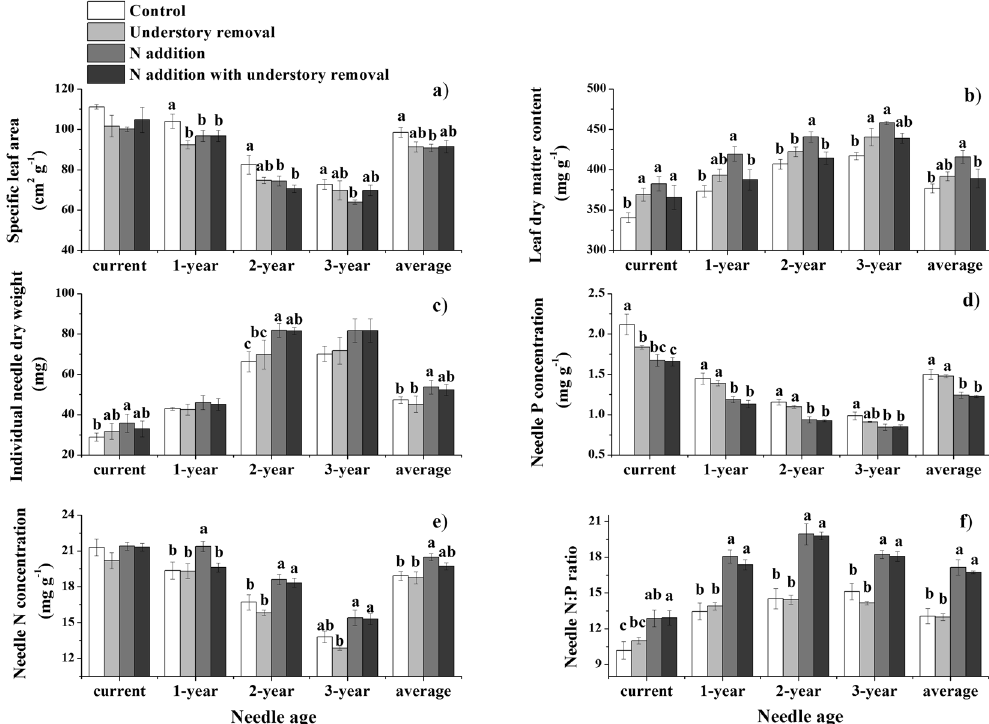
Figure 2. Changes in morphological and chemical traits of different-aged needles and their crown averages in response to N addition and understory removal in a Mongolian pine plantation. Values are means ± standard error, n = 4. Different letters within each age class indicate significant differences ( p < 0.05), according to the LSD post-hoc test following ANOVA.